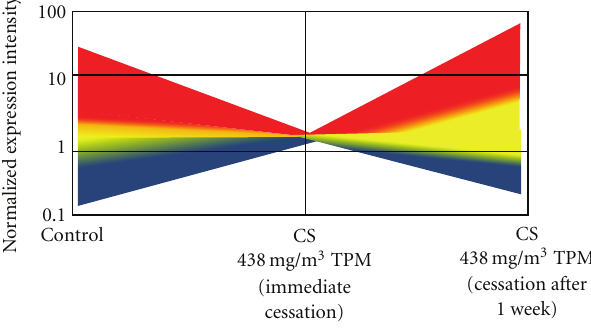
Figure 2: Persistence of miRNA in lung tissue: cartoon of a graph adapted from [36] of the intensity of expression of 697 miRNAs in the lung tissue of untreated mice or mice exposed to 438mg/m 3 TPM of cigarette smoke for 4 weeks. The mice were sacrificed either immediately (1 day) or 1 week after cessation. The blue to red gradient represents the least to most intense miRNA expressions, respectively. The graph reveals that most of the changes in miRNA expression were reversed after 1 week of